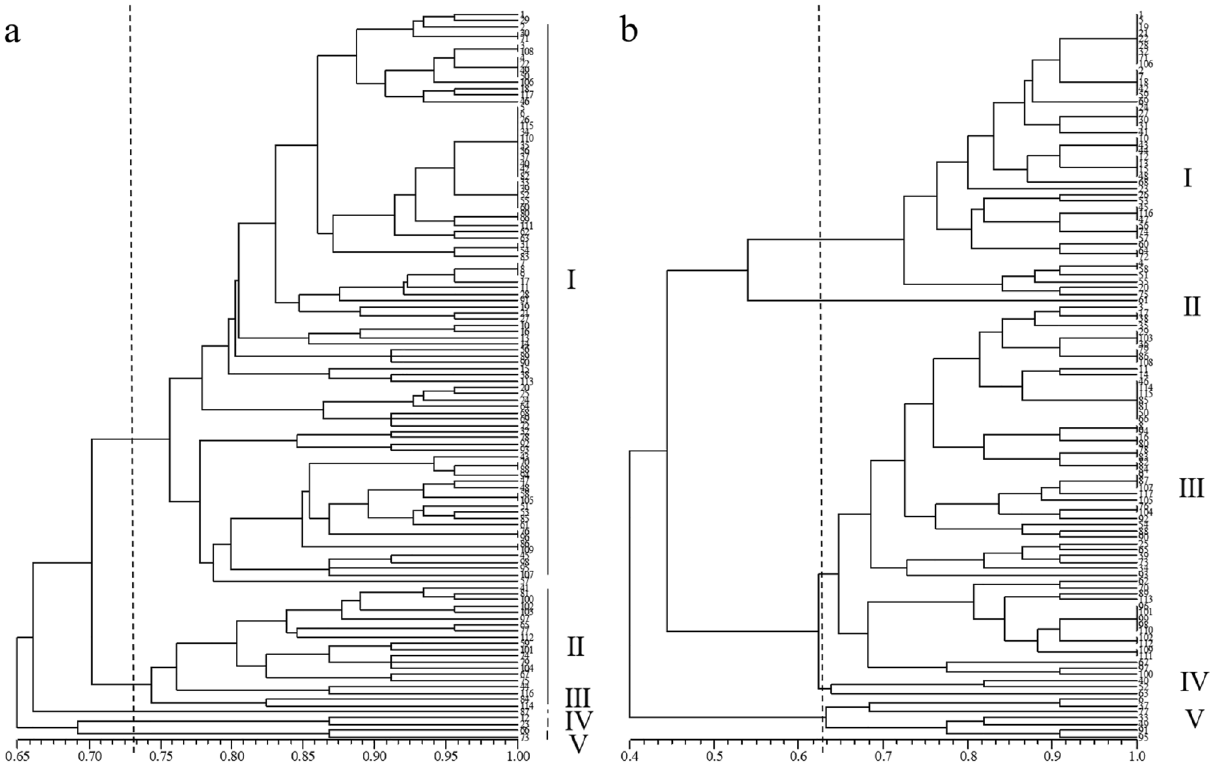
Figure 3. Cluster analysis of 117 chrysanthemum accessions with different colors using LCYE-1, LCYE-4, PSY-1a, and PSY-1b SSR markers at DNA ( a ) and cDNA ( b ) green traits when the template was DNA (Supplementary Fig. 1a and 8a), while when the template was cDNA, the clustering results of them had no correlation with flower color traits (Supplementary Fig. 1b and 8b). The CHI-1 or LCYE-1 marker could cluster the chrysanthemum accessions with green traits together when the tem- plate was DNA (Supplementary Fig. 3a and 7a), while when the template was cDNA, chrysanthemum accessions with yellow and red traits could be clustered together by CHI-1 marker and chrysanthemum accessions with green, purple and yellow traits could be clustered together by LCYE-1 marker (Supplementary Fig. 3b and 7b). When DNA was used as a template, the clustering results of the PSY-1a marker showed no correlation with chry- santhemum color traits (Supplementary Fig. 5a), but in cDNA, chrysanthemum accessions with yellow trait were clustered together (Supplementary Fig. 5b). The PSY-1b marker could cluster chrysanthemum accessions with yellow character when DNA was used as a template (Supplementary Fig. 6a), while chrysanthemum accessions with purple and yellow characters could be clustered together when the template was cDNA (Supplementary Fig. 6b). Taken together, these results implied that the markers CHS-3, 3MaT and LCYE-1 may be associated with green color and the PSY-1b marker may be associated with yellow color in chrysanthemum accessions. The SSR markers obtained from CHS-1, CHS-3, CHI-1, and 3MaT, which are the key genes in the anthocyanin biosynthesis pathway, were integrated for cluster analysis. The results indicated that the clustering results were correlated with green traits when DNA was used as template, but these SSRs were not associated with flower color when cDNA was used as template (Supplementary Fig. 9). The SSR markers LCYE-1, LCYE-4, PSY-1a, and PSY-1b obtained from genes involved in the carotenoid metabolic pathway were used to classify 117 chrysanthemum accessions together. It was found that when DNA was used as template, 117 chrysanthemum accessions were divided into five clusters, but there was no obvious clustering in flower color (Fig. 3a). When the template was cDNA, 117 chrysanthemum accessions were divided into 5 groups at a genetic distance of 0.65 (Fig. 3b). There were 40 chrysanthemum accessions in category I (including 20 yellow, 11 red, 8 white, and 1 mixed-color chrysanthemum accessions) and 7 chrysanthemum accessions in category II (including 2 yellow, 3 red, and 2 white chrysanthemum accessions). There are 60 chrysanthemum accessions in group III (including 11 yellow, 6 red, 9 white, 10 purple, 2 green, and 22 mixed- color chrysanthemum accessions), 3 chrysanthemum accessions in category IV (including 2 red and 1 white chrysanthemum accessions), and 7 chrysanthemum accessions in category V (including 2 yellow, 2 red, 1 white, 1 green, and 1 mixed-color chrysanthemum accessions). The results showed that these markers might be related to purple, yellow and multi-color characters.